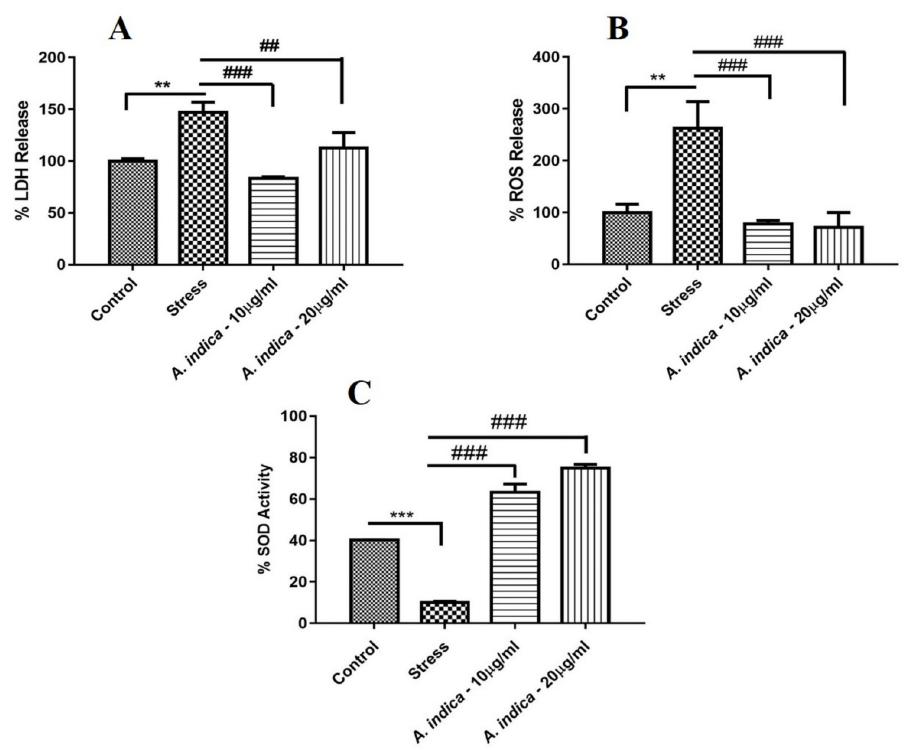
Fig 4. Effect of A . indica extract on LDH, ROS and SOD activity. (A) Activity of LDH in MIA induced hADMSCs preconditioned with A. indica extract concentrations. (B) Generation of ROS in hADMSCs preconditioned with A . indica extract and treated with MIA. (C) Percentage of SOD activity in MIA induced hADMSCs preconditioned with A . indica extract. Values are statistically significant at p � < 0.05, p �� < 0.01, p ��� < 0.001compared with the control group while p# < 0.05, p## < 0.01, p### < 0.001 compared with stress group. The experiment was carried out in triplicates (n =